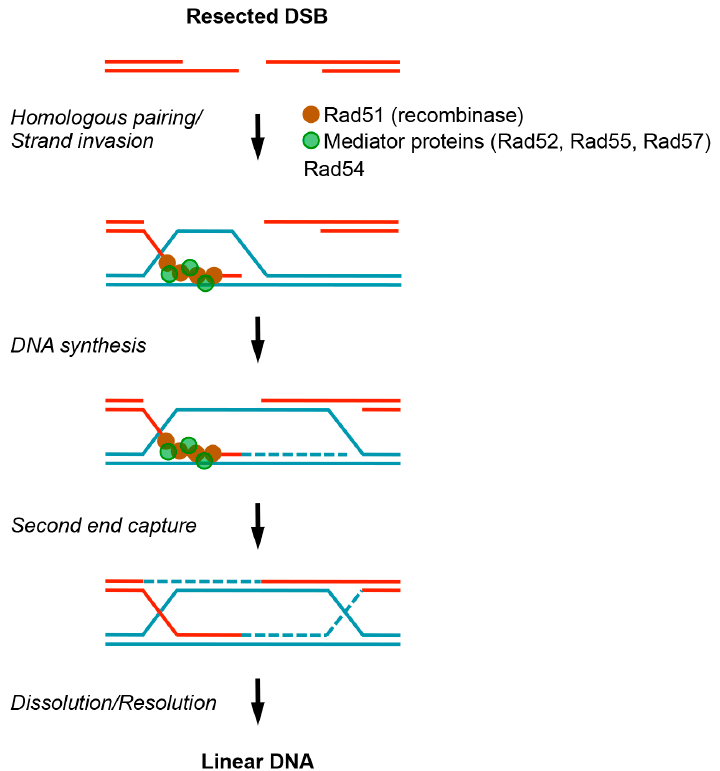
Figure 1. Simplified schematic of homologous recombination repairing DNA breaks. Recombinational repair of DNA double ‐ strand breaks (DSBs) is initiated by resection away from the break, generating ssDNA. Rad51 then forms filaments along ssDNA with the help of mediator proteins, and then together with additional factors (including Rad54), they facilitate the Rad51 ‐ ssDNA filament in homology search and strand invasion into homologous sequences. This leads to the formation of DNA D ‐ loop structures. After DNA synthesis of the invading strand, second end capture generates double Holliday junctions, which can then be processed by dissolution and resolution pathways, as described in the text. For further details, see [6,7]. This review focuses on the significant distinction between replication ‐ associated repair and DSB repair, that is the involvement of factors coupling the diverse stalled replication situations to different forms of recombinational repair. In particular, when replication forks encounter template lesions, at least three forms of recombination processes can take place (Figure 2). First, the template switch process can rescue stalled replication. In this mechanism, the newly ‐ synthesized sister chromatids, which are identical or highly homologous to the original templates, can be used to make new copies of DNA [8]. To initiate this process, proteins that generate and read various modifications of the polymerase clamp PCNA are critical, due to their roles in signaling to the recombinational factors that catalyze the template switch [8]. Second, stalled replication forks can regress and subsequently engage in recombination. In this process, nascent DNA strands dissociate from their templates and anneal with one another to form a partial duplex, allowing the template strands to re ‐ anneal [9]. After limited DNA synthesis and processing, one of the regressed strands can invade and pair with the homologous template strand to form recombination intermediates and re ‐ establish replication forks